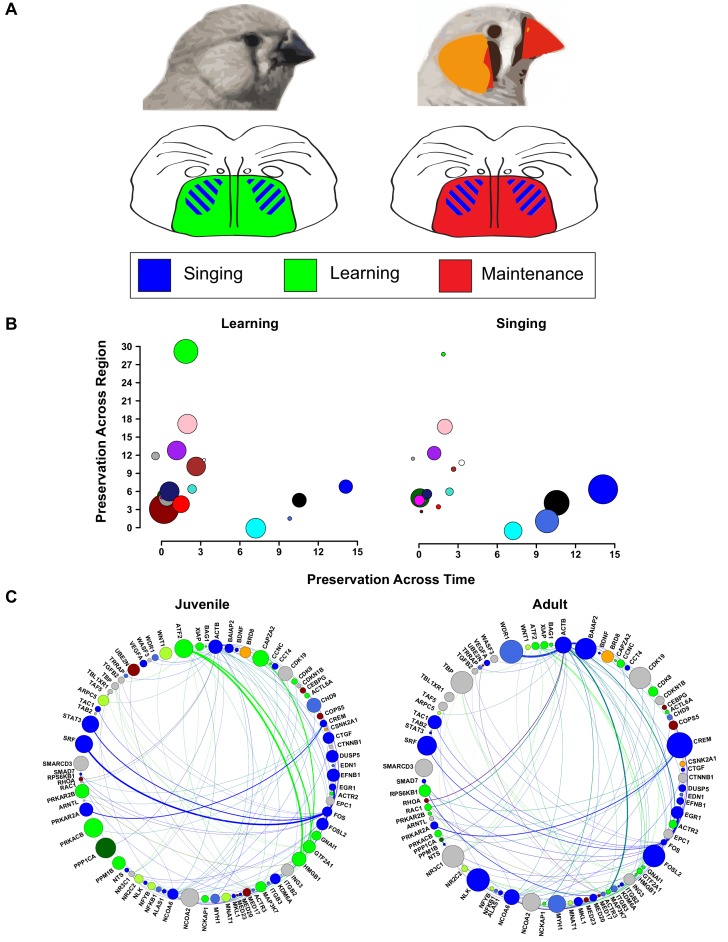
Changes in vocal plasticity state between juvenile and adult birds.(A) Schematics depict the juvenile straitopallidum (left) in a ‘plastic’ state in which genes in learning-related modules (green) are densely interconnected and of high importance in the network. Simultaneously, singing driven gene coexpression patterns (blue) occur in Area X. In the adult striatopallidum (right), song production modules (blue) exist as they do in juveniles, but the learning-related modules do not and are replaced by coexpression patterns that presumably underlie the maintenance of song (red). (B) Area X modules in the juvenile brain are plotted to emphasize their preservation in adult Area X (x-axis) and juvenile VSP (y-axis). Points representing the module colors are scaled by the module’s absolute correlation to learning (left) or the absolute correlation to singing (right), emphasizing the preservation of singing coexpression patterns into adulthood and learning coexpression patterns in the juvenile striatopallidum. (C) Genes in song production or learning-related modules that are within two steps of ATF2 in the high-confidence protein interaction network are shown. Nodes are scaled by intramodular connectivity in juveniles (left) or adults (right) with edge width indicative of adjacency between genes in the coexpression network. The change in coexpression patterns across age groups causes decreased connectivity of many learning-related genes, driving an alteration in the network’s landscape which may underlie the transition from song learning to song maintenance.